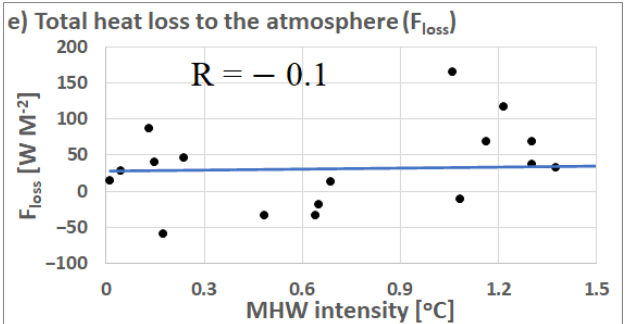
Figure 16. Scatter plots of marine heat wave intensity during the study case 3 (27 June 2019 to 22 July 2019) and surface latent heat flux ( a ), surface sensible heat flux ( b ), surface net thermal radiation ( c ), surface net solar radiation ( d ), and total heat loss to the atmosphere ( e ).